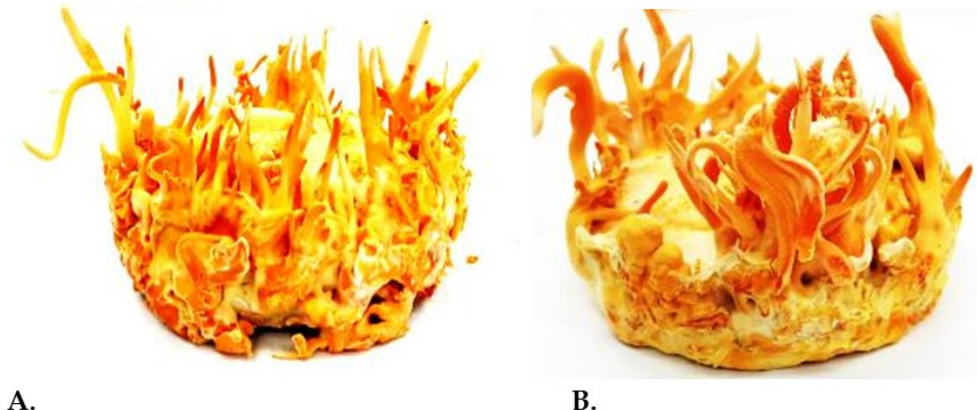
Figure 1. C. militaris strains producing ascomata following cultivation on rice-based substrates supplemented by insect tissues (Laboratory of General and Agricultural Microbiology, Agricultural University of Athens, Greece); ( A ) strain CmDK1, ( B ) strain CmDK2 [76].